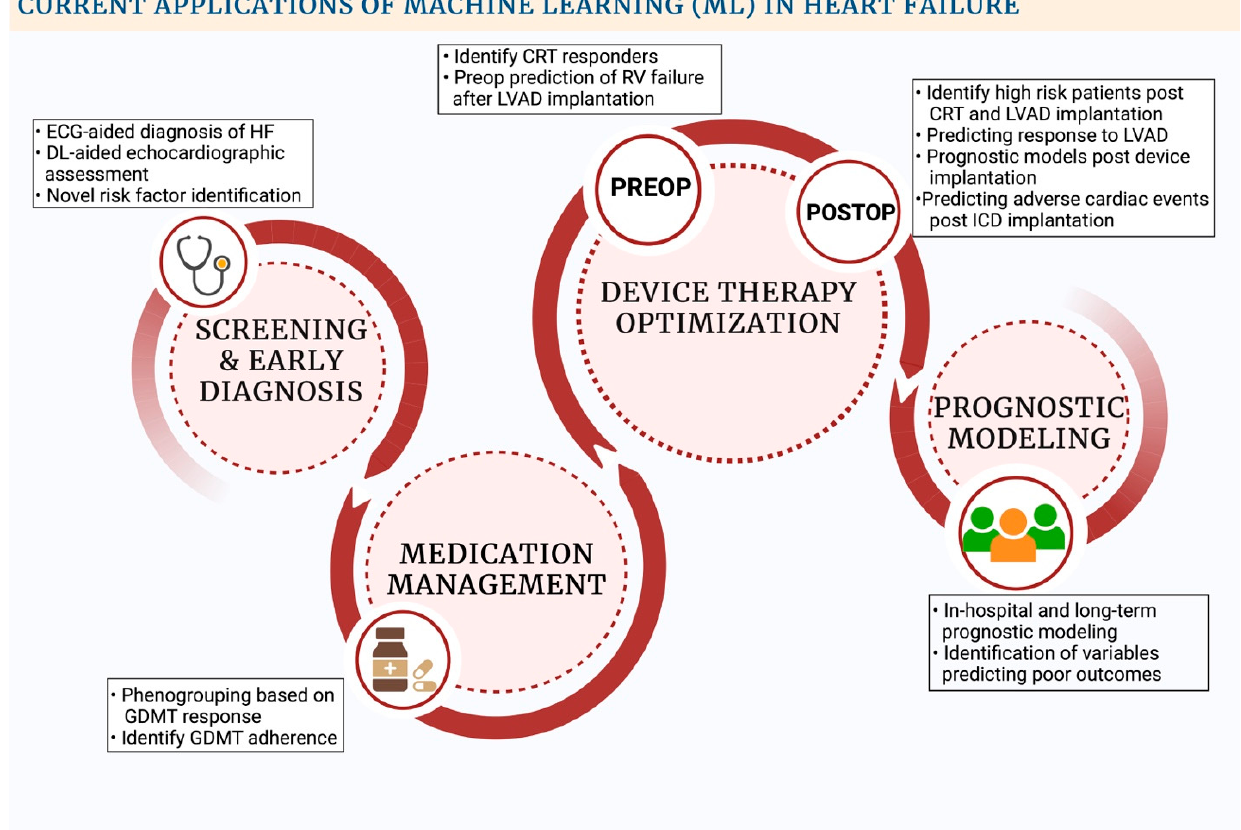
Figure 2. Current applications of machine learning in Heart Failure. Abbreviations: CRT: Cardiac resynchronization therapy; DL: Deep learning; ECG: Electrocardiogram; GDMT: Guideline-directed medical therapy; ICD: Implantable cardiac defibrillator; LVAD: Left Ventricular Assist Device; RV: Right Ventricle.